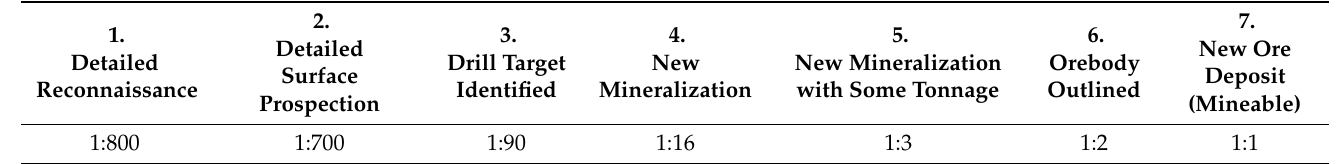
Table 1. Probability of an exploration project becoming a profitable mine in the second half of the 20th century